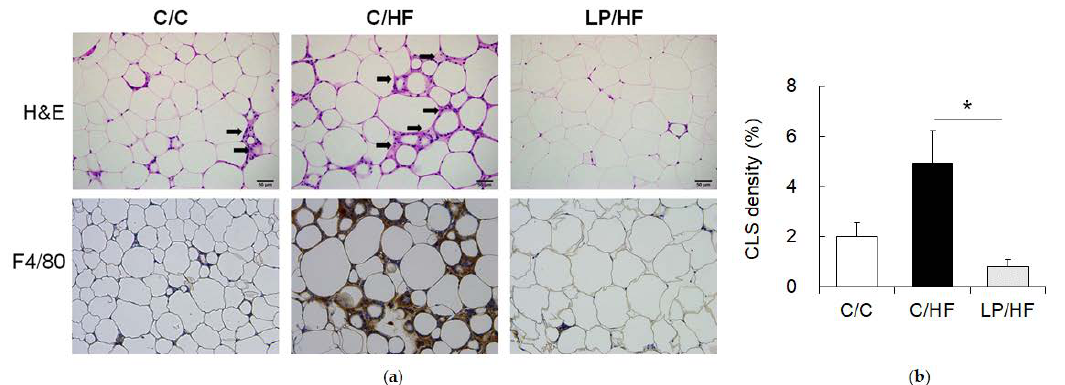
Figure 1. Histological analysis of epididymal adipose tissue. ( a ) Upper figures are representative H&E staining of epididymal adipose tissue section (magnification 200 × ). Crown-like structures (CLS) are indicated with the black arrow. Lower figures are representative immunostaining with macrophage infiltration marker F4 / 80 antibody (brown) from the same tissue section. Scale bar represents 50 µ m. ( b ) Quantification of CLS density of the H&E stained section. Data are presented as means ± SEM ( n = 3). * P < 0.05 (independent t -test).